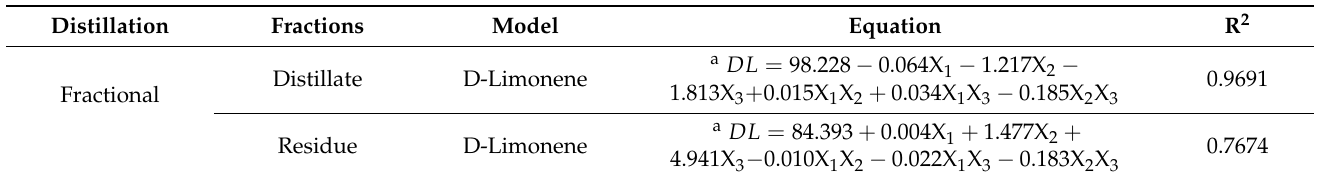
Table 8. Predictive models in fractional distillation (distillate and residue) for D-Limonene and its correlation coefficient.